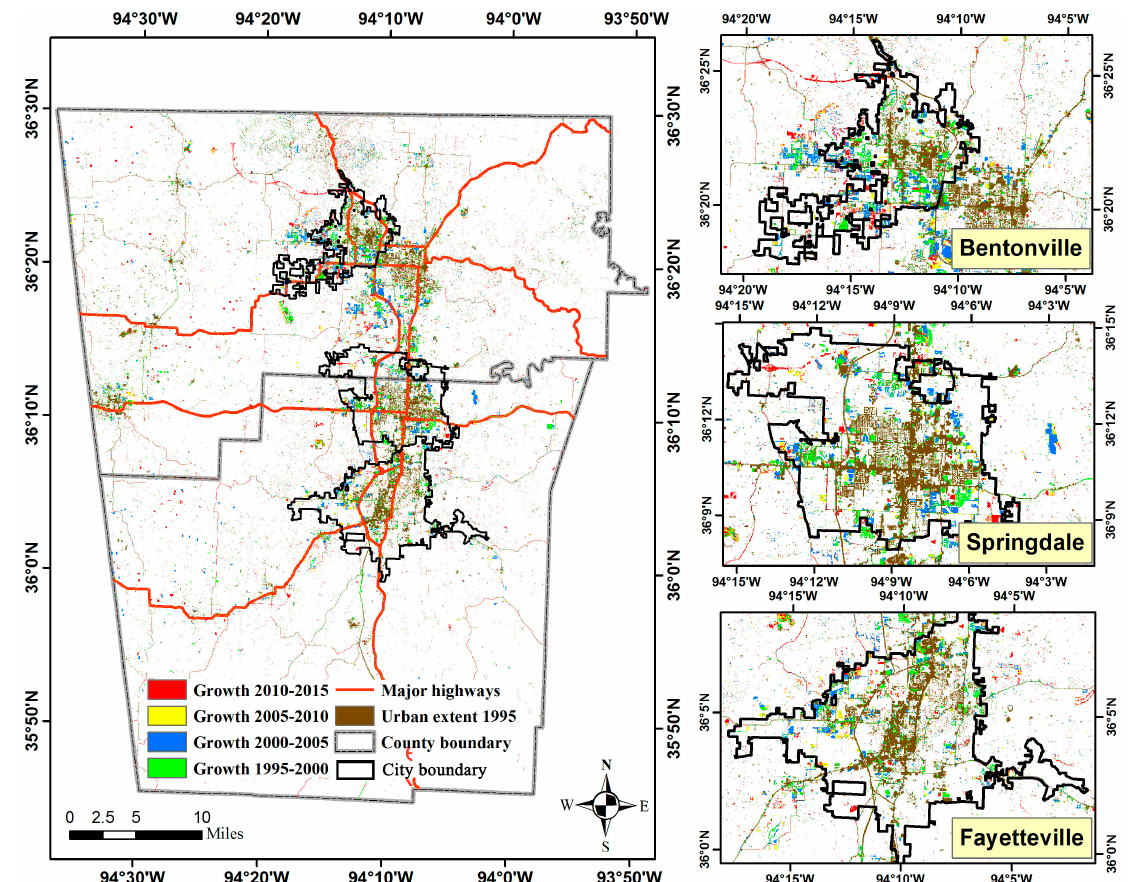
Figure 7. Urban expansion in NWA from 1995 to 2015, and enlarged view of Bentonville, Springdale, and Fayetteville.